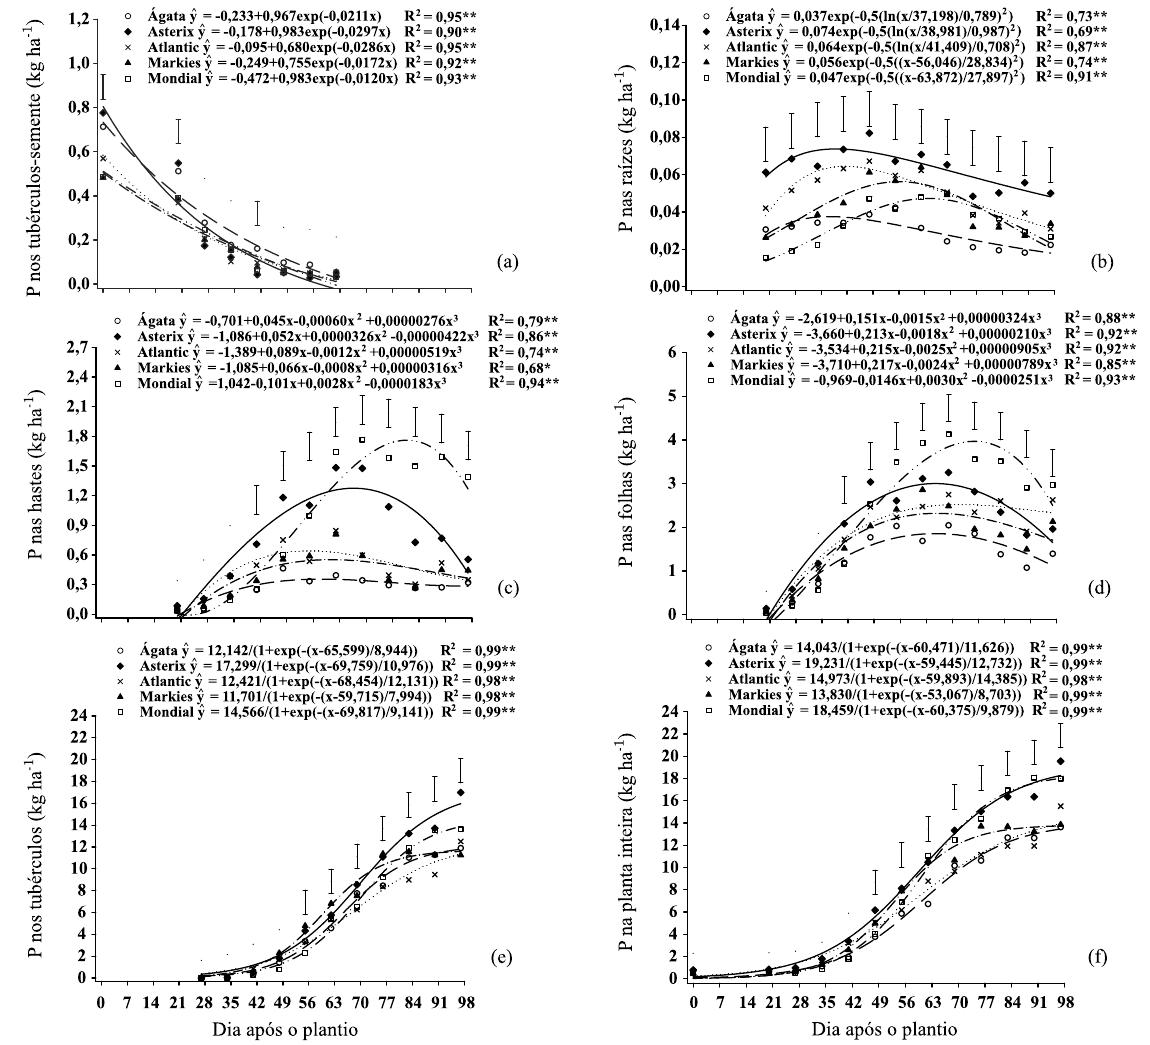
Figura 3. Quantidade de P nos tubérculos-semente (a), raízes (b), hastes (c), folhas (d), tubérculos (e) e na planta inteira (f) de cultivares de batata ao longo do ciclo. ** significativo a 1 % pelo teste F. Barras verticais indicam o valor de DMS pelo teste de Tukey a 5